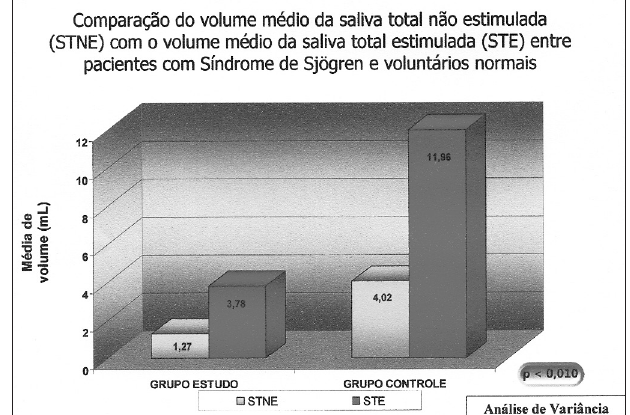
Figura 1. Volume médio salivar em individuos com Sjögren (grupo estudo) e em indivíduos saudáveis. STNE - Saliva Total Não Estimulada. STE - Saliva Total Estimulada.